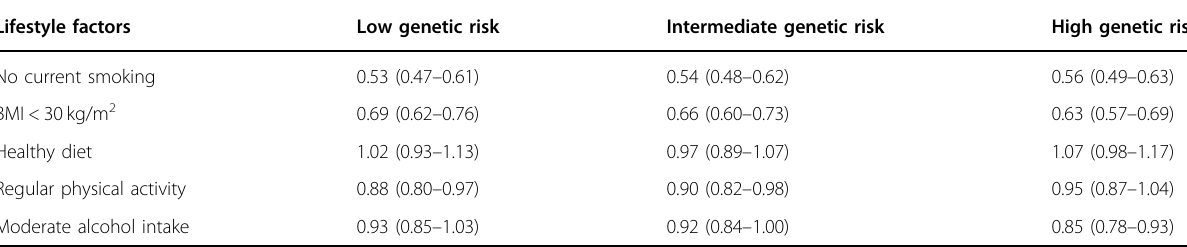
Table 3 Multivariable Cox regression analysis of individual lifestyle factors in relation to risk of depression, strati fi ed by genetic